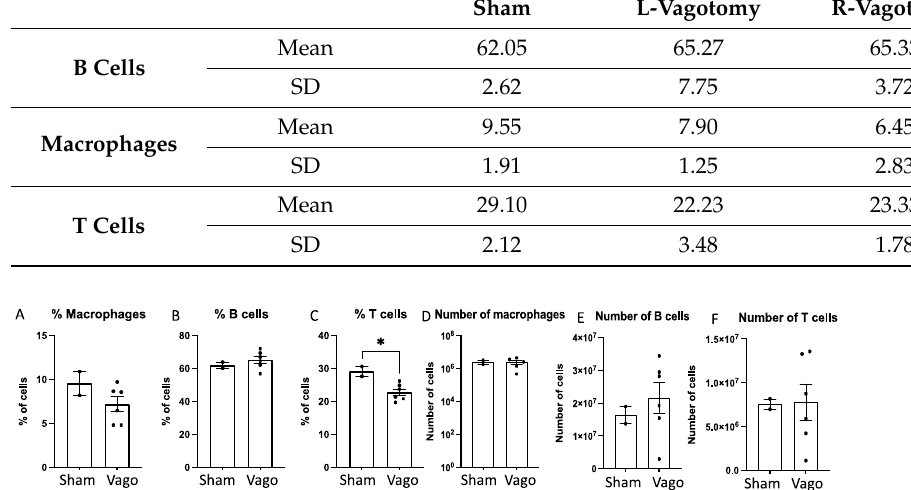
Figure 1. Vagotomy alters the splenic immune profile. Left and right unilateral vagotomy (Vago) groups were combined and their immune profiles were compared to sham vagotomy (Sham) mice. In ( A ), a modest decrease in percent macrophages was observed in the vagotomy group, but the overall number of macrophages ( D ) was unchanged. In ( B , E ), there were no significant changes to the percent or number of total B cells, respectively. In ( C ), the percent of T cells is significantly less in the vagotomy group, whereas in ( F ), the total number of T cells is not significantly different. Thus, there appears to be a shift in the distribution of splenic immune cells after vagotomy, with lower percentages of macrophages and T cells. * p < 0.03.